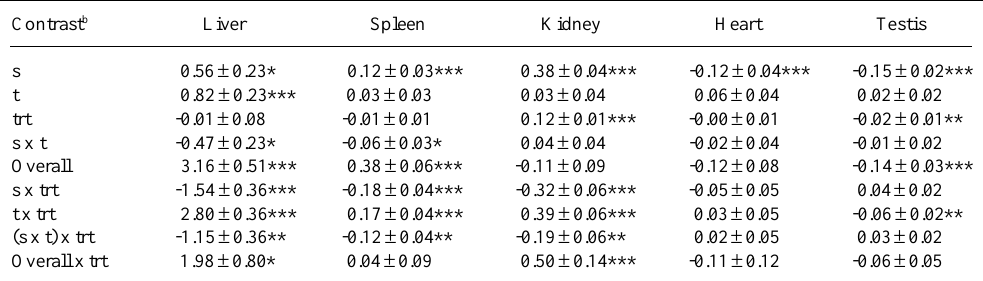
Table IV - Orthogonal contrasts ± SE involving NC, NM, TC, TM and CC lines a for organ weights as a percentage of 8-week body weight (%).